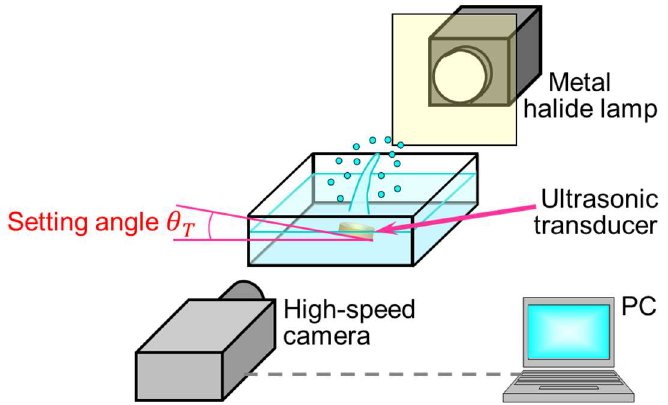
Figure 1. Schematic diagram of the experimental system for visual observation of ultrasonic atomi- zation process for inclined liquid